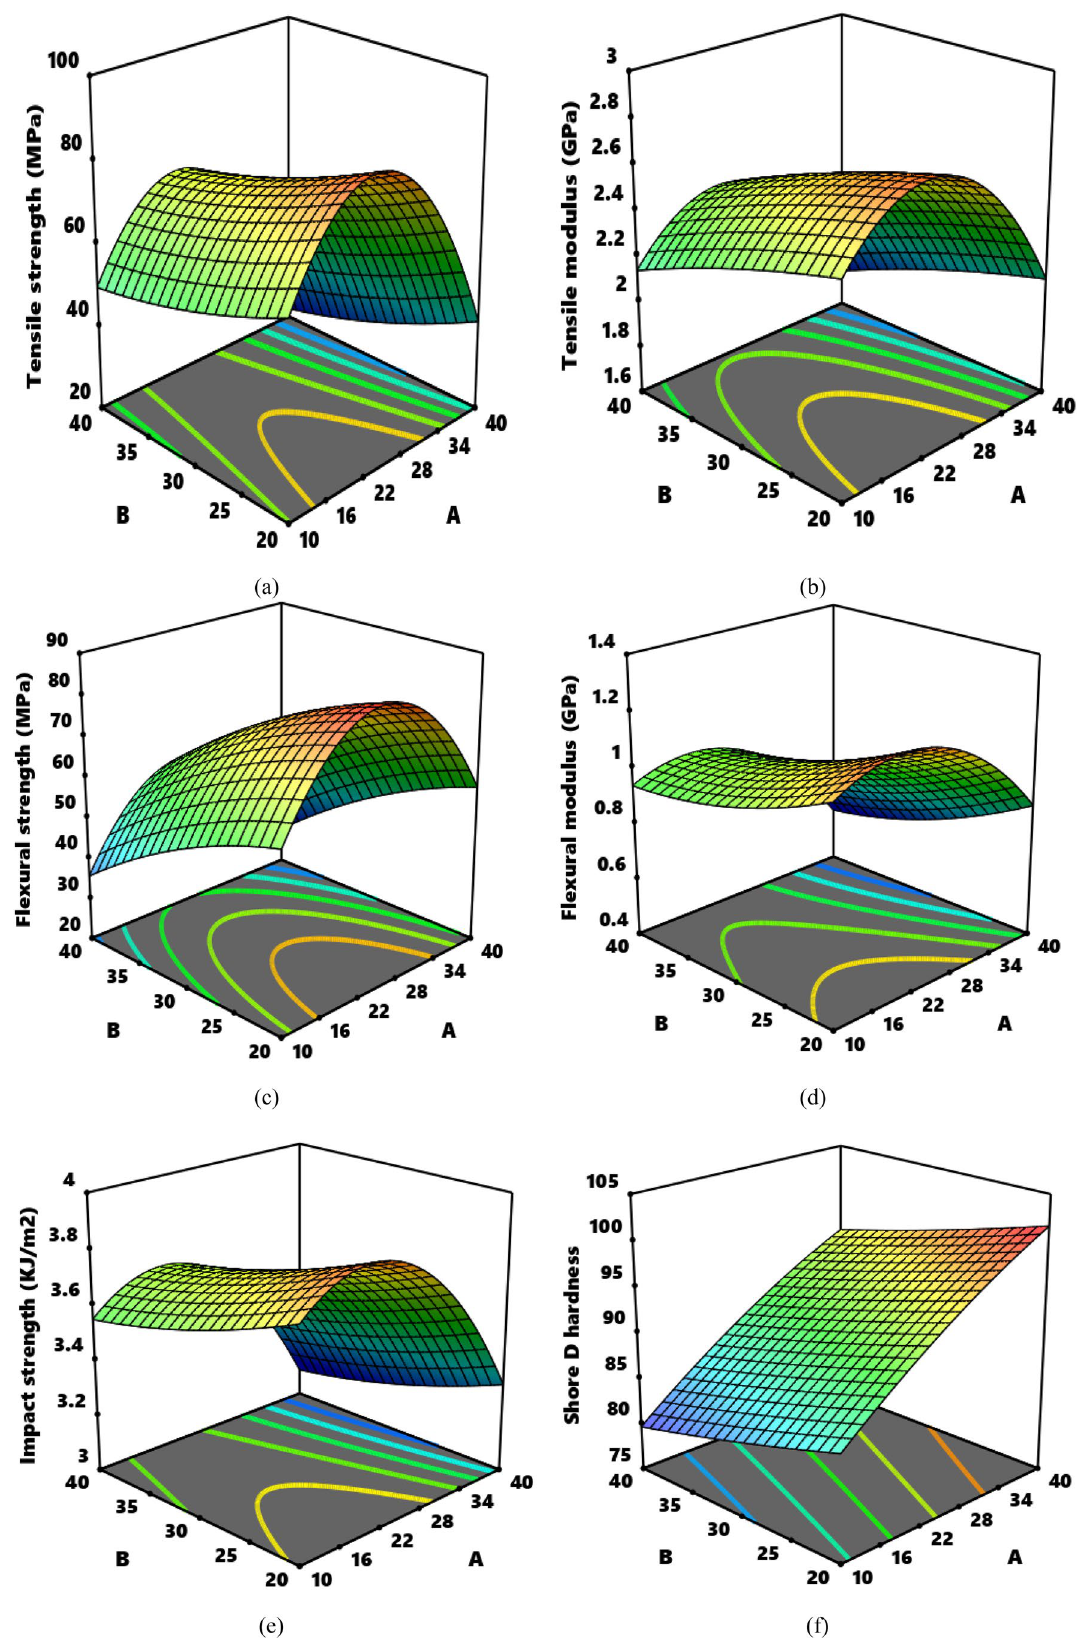
Figure 5. Surface plots for the relationship particulate proportion vs particulate size with respect ( a ) tensile strength ( b ) tensile modulus ( c ) flexural strength ( d ) flexural modulus ( e ) impact strength ( f ) hardness. A is particulate proportion, B is particulate